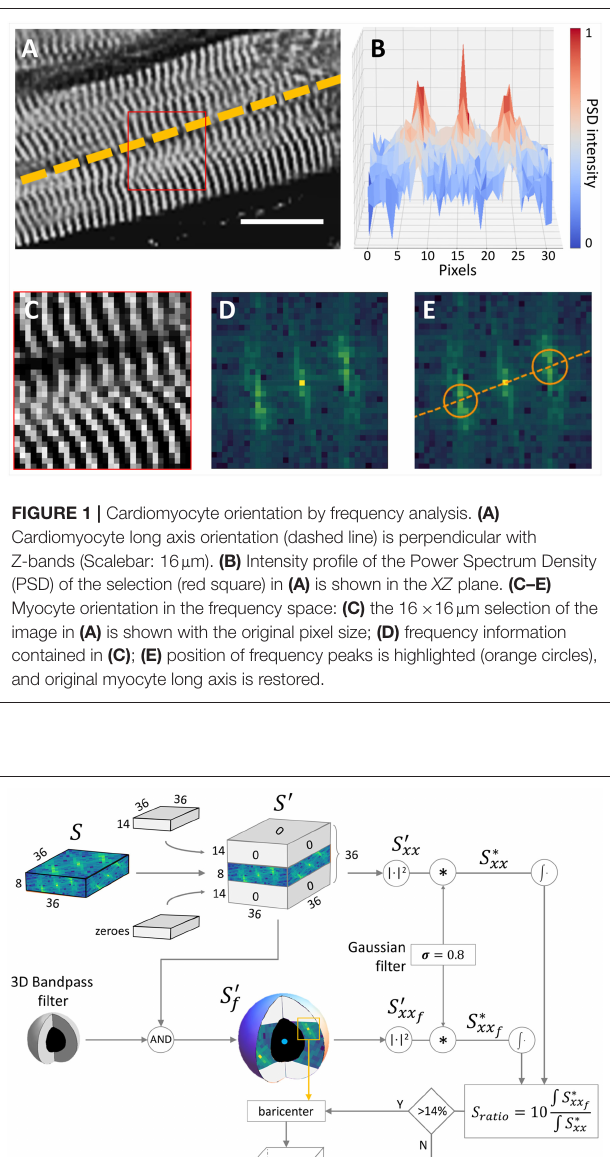
analyzed only if containing at least the 80 % of contractile tissue to discard borders